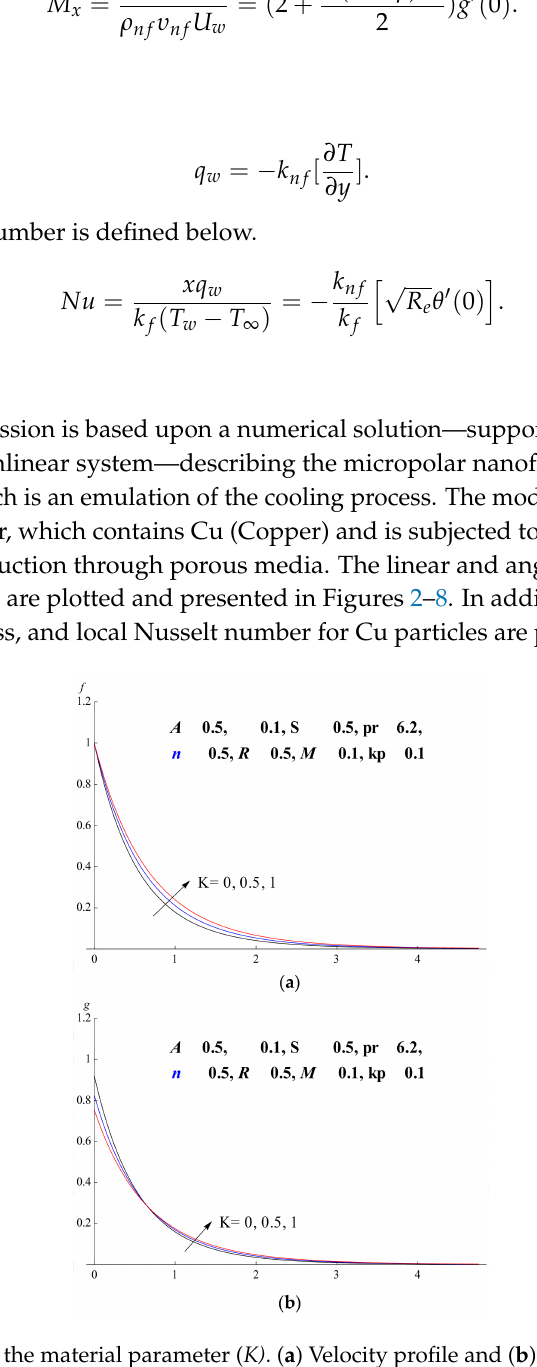
Figure 2. Influence of the material parameter ( K) . ( a ) Velocity profile and ( b ) angular velocity